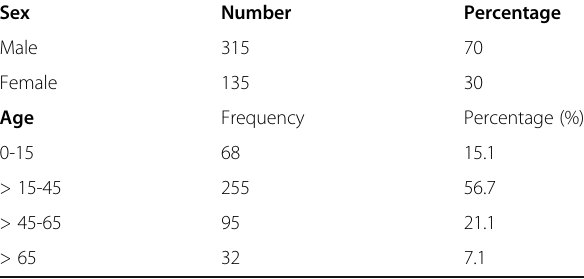
Table 1 Demography of cases seen by the neurosurgical unit at the Irrua Specialist Teaching